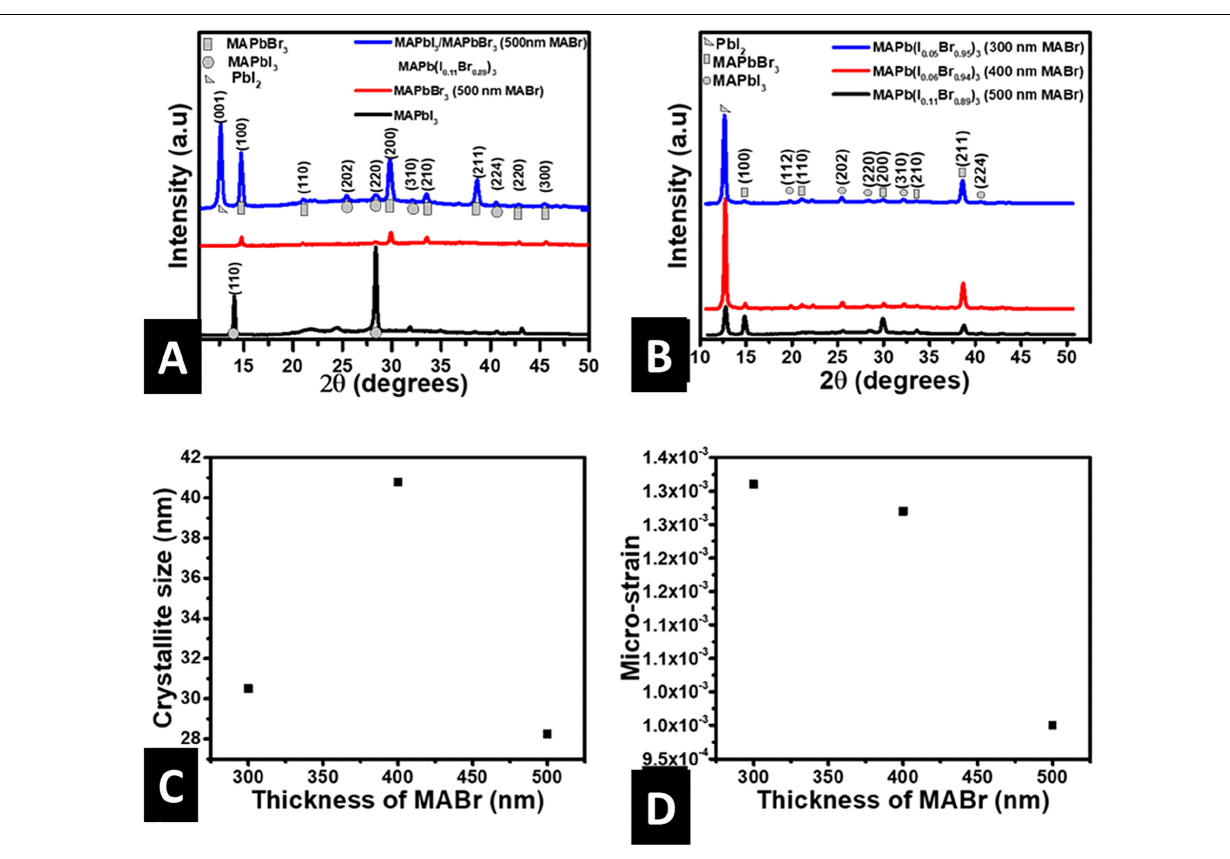
FIGURE 2 | (A) XRD patterns of MAPbI 3 , MAPbBr 3 (500 nm of MABr) and MAPbI 3 /MAPbBr 3 , (B) XRD patterns of MAPb(I 1 − x Br x ) 3 for various thicknesses of MABr, (C) crystallite size against MABr thickness for MAPb(I 1 − x Br x ) 3 thin-films, (D) microstrain against MABr thickness for MAPb(I 1 − x Br x ) 3